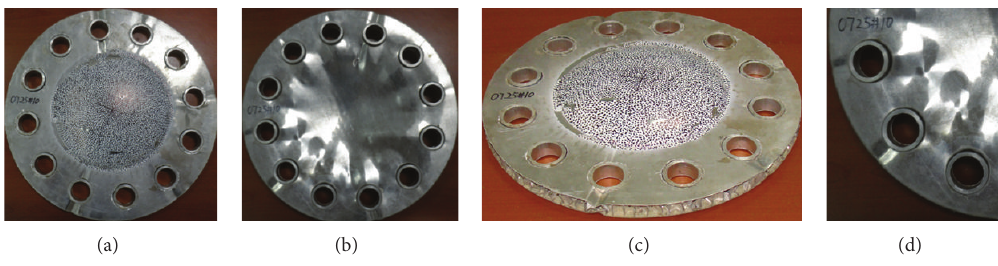
̂𝐼 = 1.067 : (a) and (b) show the dry and the wet face sheets; (c) shows a side